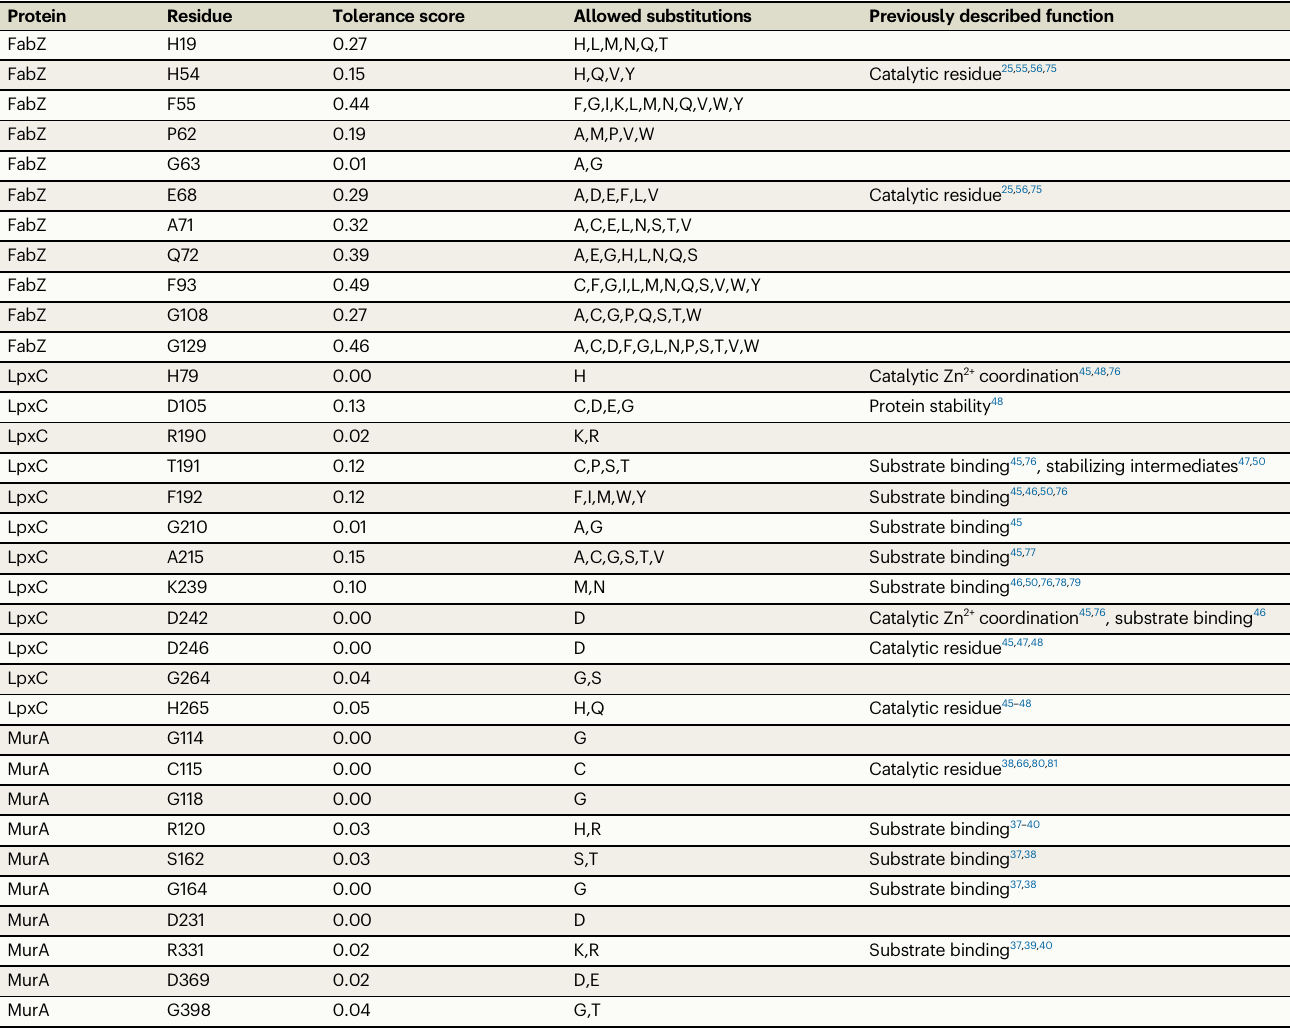
Table 1 | Selected surface exposed residues with relatively low tolerance scores for FabZ, LpxC and MurA